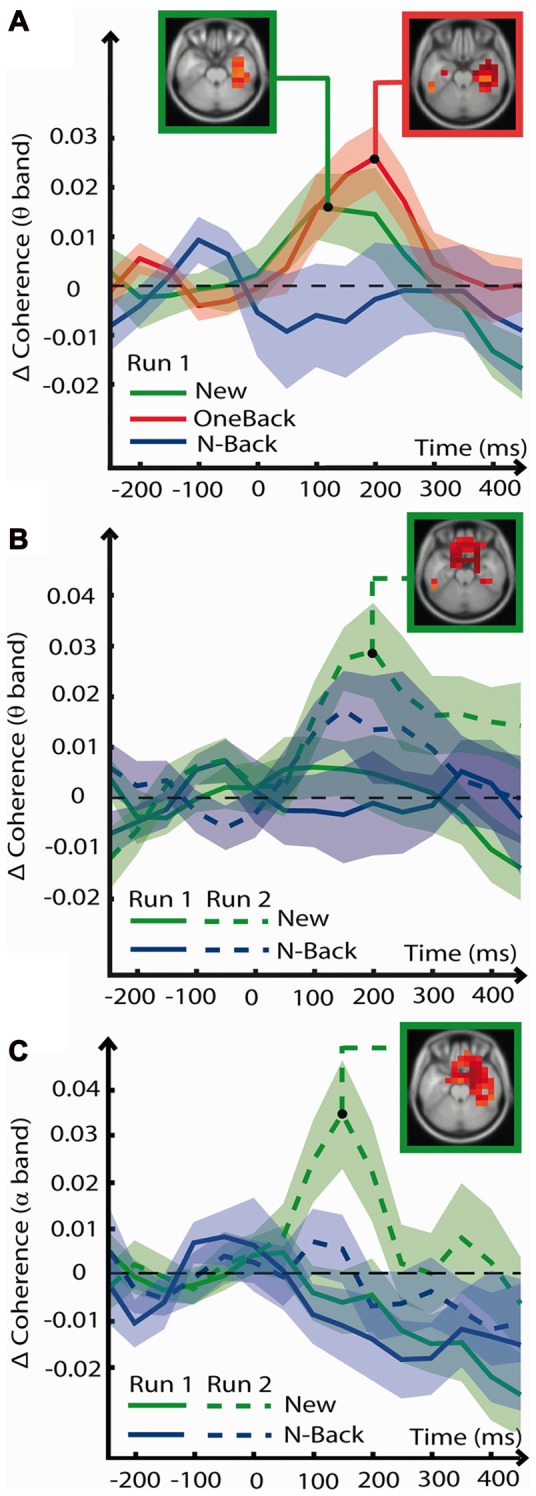
Coherence analysis. Event-Related Coherence (ERCoh) between voxels of various brain areas in various frequencies of oscillation as a function of time (x axis) and coherence change from baseline (y axis). When relevant for a specific stimulus, voxels of significant ERCoh change (t(17) > 2.57, p < 0.01, cluster correction) are displayed in a box on a slice of MRI template. (A) ERCoh in the theta frequency from voxels of the right hippocampal complex (HC) in response to stimuli of the encoding condition (New1, Oneback1 and N-Back1). Voxels with significant ERCoh increase are displayed in the red box for OneBack1 in the MTL at 200 ms and in the green box for New1 also in the MTL at 100 ms. (B) ERCoh in the theta frequency from voxels of the OFC in response to stimuli of the ORFi condition (New1, New2, N-Back1 and N-Back2). Voxels with significant ERCoh change in the OFC at 200 ms and in response to New2 are displayed in the green box. (C) ERCoh in the alpha frequency from voxels of the OFC in response to the ORFi condition. Voxels with significant ERCoh change at 150 ms in response to New2 are visible in the OFC and MTL and are displayed in the green box.